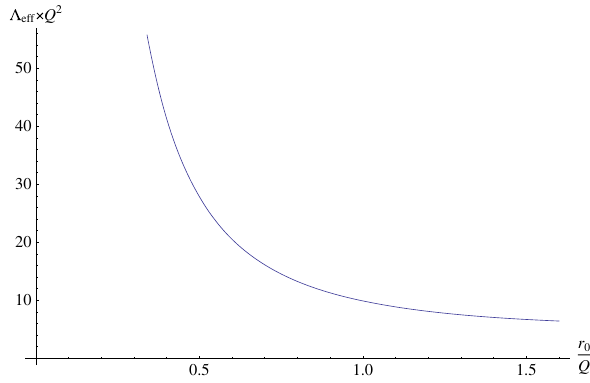
Fig. 2 The reduced effective cosmological constant is plotted in terms of the reduced horizon radius for the case of the extremal black hole The event horizon radius r + is taken as the largest positive root of f ( r )